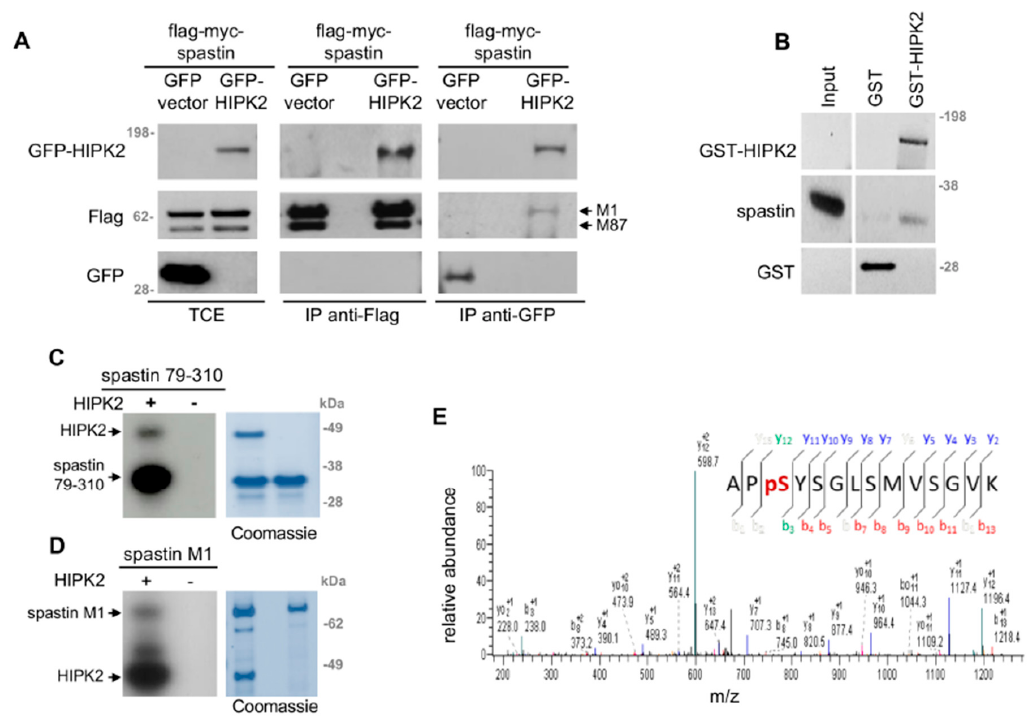
Figure 3. HIPK2 phosphorylates spastin at S268. ( A ) HeLa cells were transfected with the indicated combination of vectors. Exogenous flag-myc-tagged spastin, expressing both M1 and M87 isoforms, was immunoprecipitated with anti-Flag (mouse Ab by OriGene Technologies), or exogenous GFP-tagged HIPK2 was immunoprecipitated with anti-GFP (mouse Ab by Roche). WB for indicated proteins was performed by using anti-Flag (rabbit Ab by Sigma-Aldrich) and anti-GFP (rabbit Ab by Santa Cruz Technology). Different exposure times for TCE and IP are shown. ( B ) GST and GST-HIPK2 proteins were produced by T7-vaccinia system in H1299 cells, purified by GST pull-down, and incubated with an equal amount of recombinant His 6 -tagged spastin 79–310. Spastin binding was detected by WB. Input = 50 ng of recombinant spastin. Representative WB is shown (blot was vertically cropped to eliminate non-related samples). ( C ) In vitro kinase assay was performed by using HIPK2 kinase domain (HIPK2) as the enzymatic source and His 6 -tagged spastin 79–310 as the substrate in presence of γ -ATP-P 32 . Representative autoradiography and relative Coomassie blue staining are shown. ( D ) In vitro kinase assay, performed as in C by using flag-myc-tagged spastin full-length M1 as the substrate. Representative autoradiography and relative Coomassie blue staining are shown. ( D ) In vitro kinase assay, performed as in C, by using cold ATP and analyzed by MS. The ion 731.9, corresponding to the phosphorylated spastin peptide (266–279) encompassing S268, was fragmented, producing a MS2 spectrum with the most intense ion 628.9. This ion revealed a 49 Da neutral loss and was further fragmented in the MS 3 spectrum that is shown.